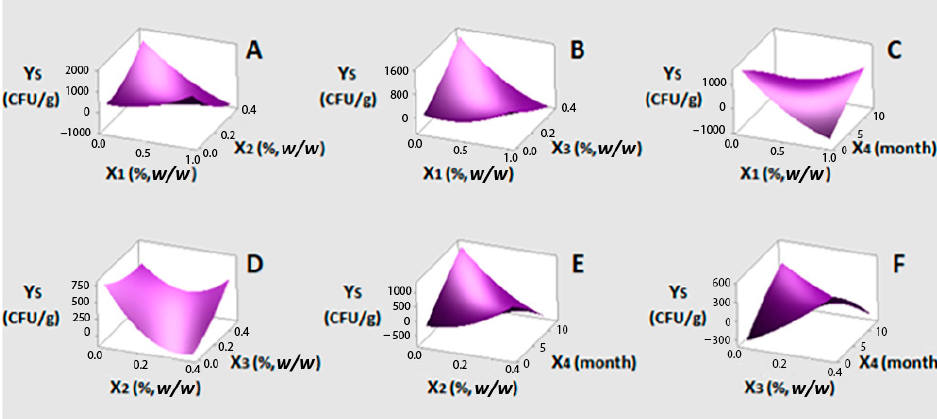
Figure 1. A-F three-dimensional surface plots for Staphylococcus spp. growth (Y S , CFU/g) as a function of oregano (X 1 %, w/w ), lemon balm (X 2 %, w/w ), bay laurel (X 3 %, w/w ) EOs contents and time (X 4 , month). In all cases, the rest factors were kept constant at their middle levels (0.5%, 0.25% and 0.25% w/w and seven months, respectively).